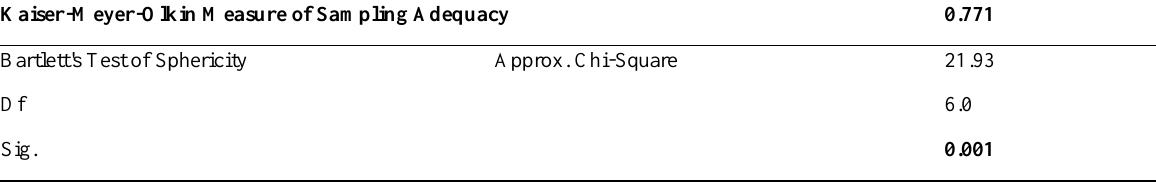
Table 3: Kaiser-Meyer-Olkin Measure of Sampling